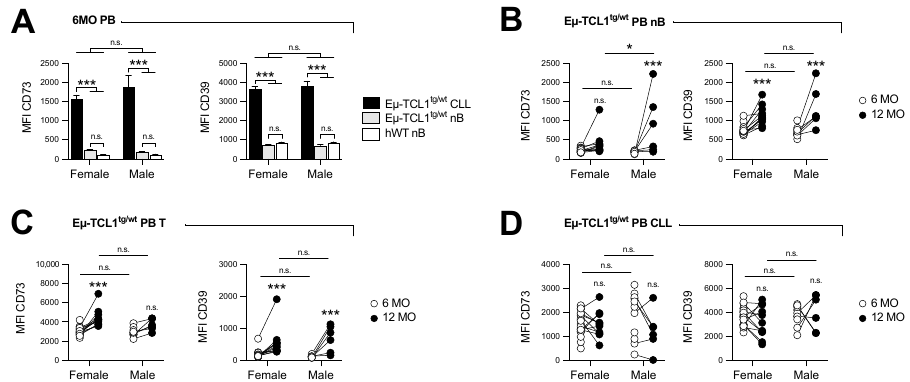
Figure 1. CD73 and CD39 expression is upregulated on non-leukemic lymphocytes upon disease progression. Peripheral blood (PB) cells of male (M) and female (F) Eµ-TCL1 tg/wt mice were analyzed at 6 months old (Mo) (early stage; n = 25 F and n = 11 M) and 12 months old (Mo) (advanced stage; n = 11 F and n = 6 M). CD73 (left) and CD39 (right) expression levels are shown by mean fluorescence intensity (MFI). ( A ) CD73 and CD39 expression is compared between 6-month-old PB leukemic cells (CLL; CD5 int B220 int ) and normal B cells (nB; CD5 neg B220 hi ) from Eµ-TCL1 tg/wt and hWT mice ( n = 5 M and 5 F). ( B – D ) CD73 and CD39 expression is compared between 6- and 12-month-old ( B ) normal B cells (nB), ( C ) pan-T cells (T; CD5 hi B220 neg ) and ( D ) leukemic cells (CLL) of Eµ-TCL1 tg/wt mice. Means +/ − SEM are shown (* p < 0.05; *** p < 0.001 by 2-way ANOVA). MO, months; PB, peripheral blood; n.s., non-significant; nB, normal B cells; MFI, mean fluorescence intensity; hWT, healthy WT. 3.2. CD73 Deficiency Prolongs Survival of Eµ-TCL1 Male Mice in an IFN- γ -Dependent Manner Next, we crossed Eµ-TCL1 tg/wt mice with CD73 − / − mice and analyzed disease progres- sion and survival. We observed that CD73 deficiency significantly increased the survival of male CD73 − / − Eµ-TCL1 mice (log-rank p = 0.002) (Figure 2A and Table 1). Consistent with this observation, peripheral disease burden was also significantly reduced at 12 months (Figures 2C and S2A). Surprisingly, no survival difference was observed in female mice (log-rank p = 0.54) (Figure 2B and Table 1). CD73-deficient female Eµ-TCL1 tg/wt mice showed a similar disease burden to that of control female mice (Figures 2D and S2B).